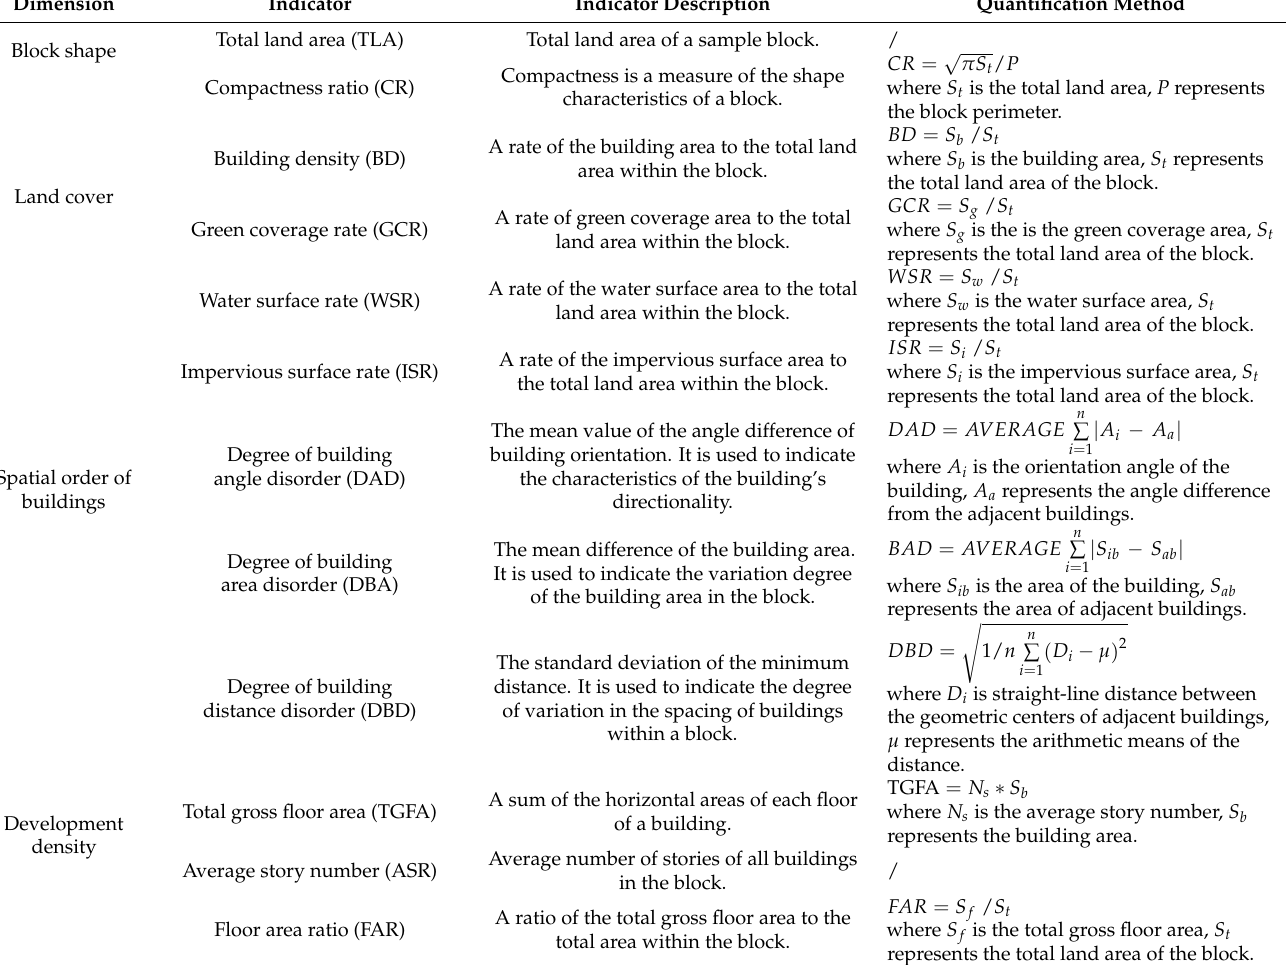
Table 2. Common dimensions and indicators for morphological evaluation.